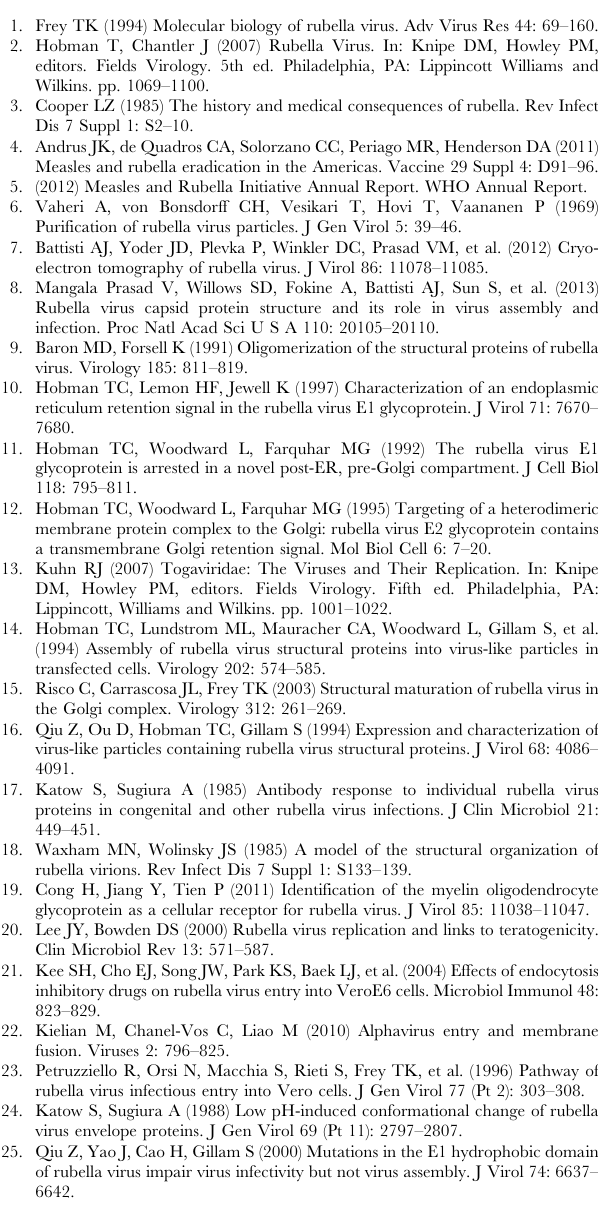
Figure S5 Trypsin-resistant RuV protein species are derived from the E1 protein. Purified radiolabeled RuV was treated at the indicated pH for 5 min at 37 u C and digested with trypsin with or without inhibitor as in Figure 5C. Samples were then precipitated with mAbs to E1 or E2 and analyzed by SDS- PAGE and autoradiography. Figure S6 The E1 N88A and D136A mutations inhibit virus fusion at the plasma membrane. A fusion infection assay was performed as described in Fig. 3A, using WT RuV (MOI = 2.5) and an equivalent volume of the RuV E1 N88A,D136A and N88A,D136A virus stocks. Fusion medium was supplemented with 2 mM CaCl 2 (WT) or 2 and 20 mM CaCl 2 (mutants). Graph shows the range and mean of 2 independent experiments.